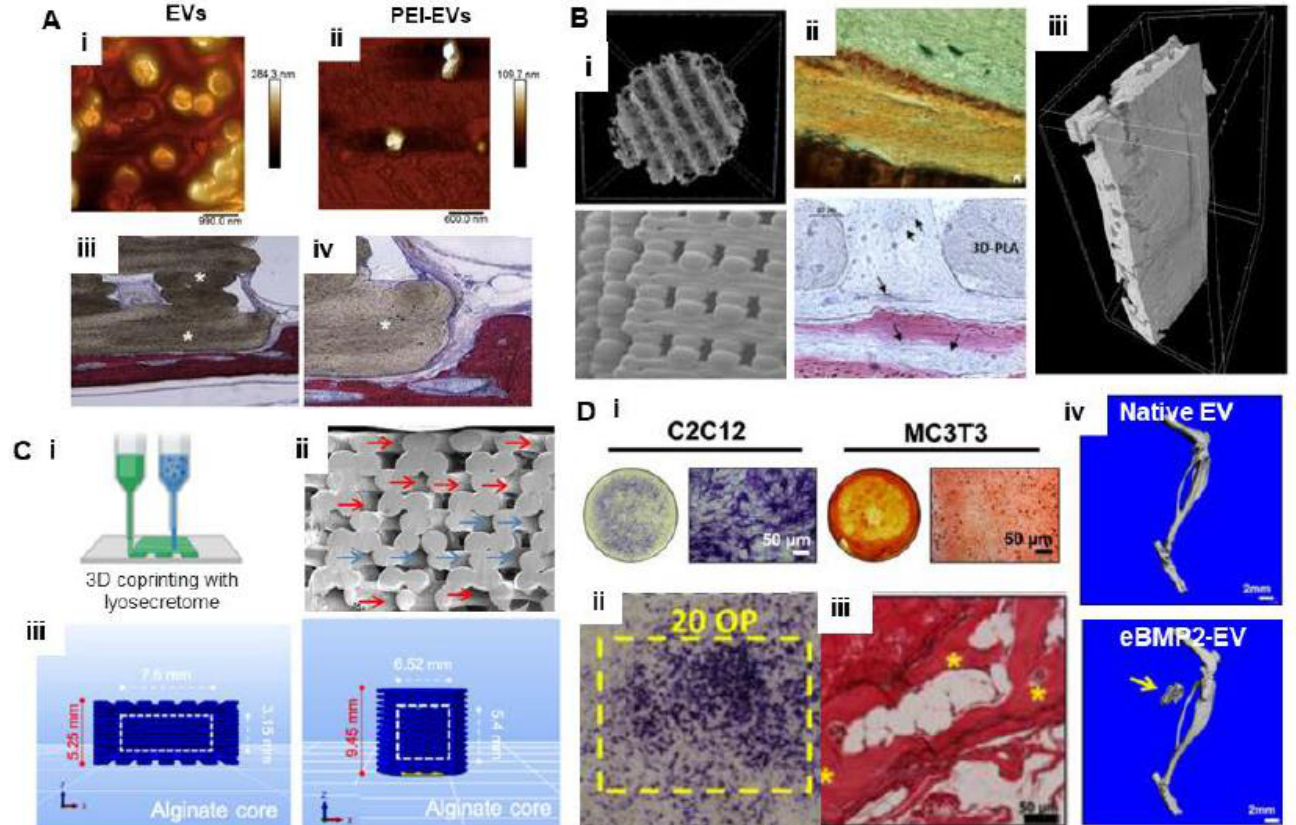
Figure 7. ( A ) Three-dimensional-printed poly(lactide) (PLA) scaffold and human gingival stem cell-derived (hGMSCs) extracellular vesicles (EVs). (i,ii) Topographic AFM image showing round morphology of EVs and polyethyleneimine (PEI)-engineered EVs (PEI-Evs); (iii) the images at low magnification showed construct integrated smoothly with the host; (iv) high-magnification images showing the new bone formation stained with acid fuchsin in both samples grafted at 6 weeks postsurgery (adapted and reproduced from [148]) . ( B ) Three-dimensional-printed poly(lactide) (PLA)/Gingival Stem Cells/ Evs. (i) Representative µCT picture and SEM acquisition of 3D-printed PLA (3D-PLA); (ii) histological evaluation in vivo. After six weeks of grafting, samples were stained with von Kossa silver staining or Methylene blue and acid fuchsin images for the 3D-PLA/hGMSCs/Evs sample. Black arrows indicated blood vessels. Scale bar: 50 µ m; (iii) 3D-MicroCT analysis showing 3D volume rendering and virtual transverse sectioning of 3D-PLA/hGMSCs/EVs (adapted and reproduced from [149]). ( C ) Three-dimensional coprinting of PCL with an alginate-based hydrogel encapsulating lyosecretome (i). (ii) SEM morphological and structural characterizations of 3D-printed PCL scaffolds loaded with lyosecretome. Presence (red arrows) or absence (blue arrows) of material deposition on PCL fibers is indicated. (iii) Scaffold geometry and dimensions of coprinting parallelepiped- and cylindrical-shaped scaffolds with a “soft heart” of lyosecretome-laden alginate (i.e., bioink) (adapted and reproduced from [150]). ( D ) Osteoblastogenesis by extracellular vesicle-associated bone morphogenetic protein 2. (i) Representative bright-field images of ALP assay (C2C12 cells) and mineralization assay (MC3T3 cells); (ii) ALP staining of C2C12s post-72 h seeding on bioprinted patterns with indicated 20 overprints (Ops); (iii) histological images showing H&E and Masson’s trichrome staining of BMP2-EV-bioprinted implants (* indicates bone tissue); (iv) representative µ CT 3D reconstructions of mouse leg scans containing either native EV or BMP2-EVs bioprinted implants. Arrow points to heterotopic ossification (adapted and reproduced from